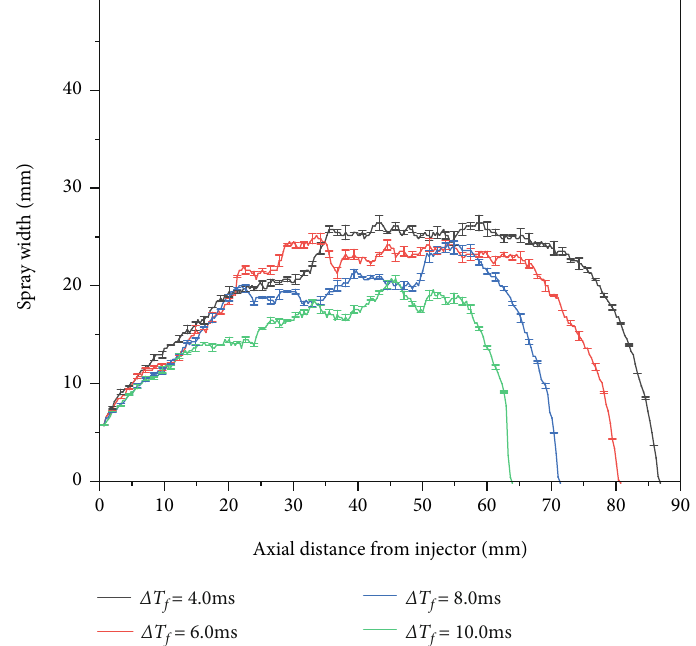
= 0 : 8MPa , T = 298 K f f